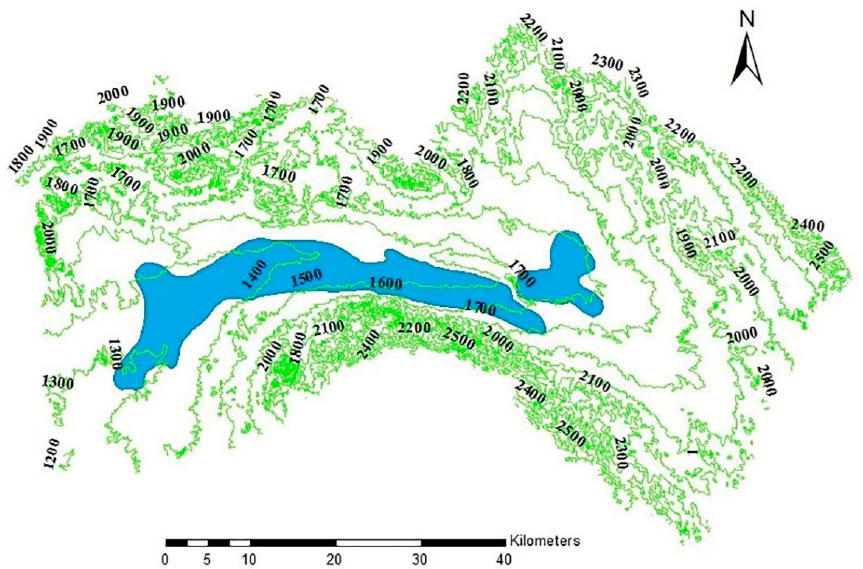
Figure 10. Topography of the Birjand watershed which includes the Birjand aquifer. The numbers represent the elevation in m.s.l.